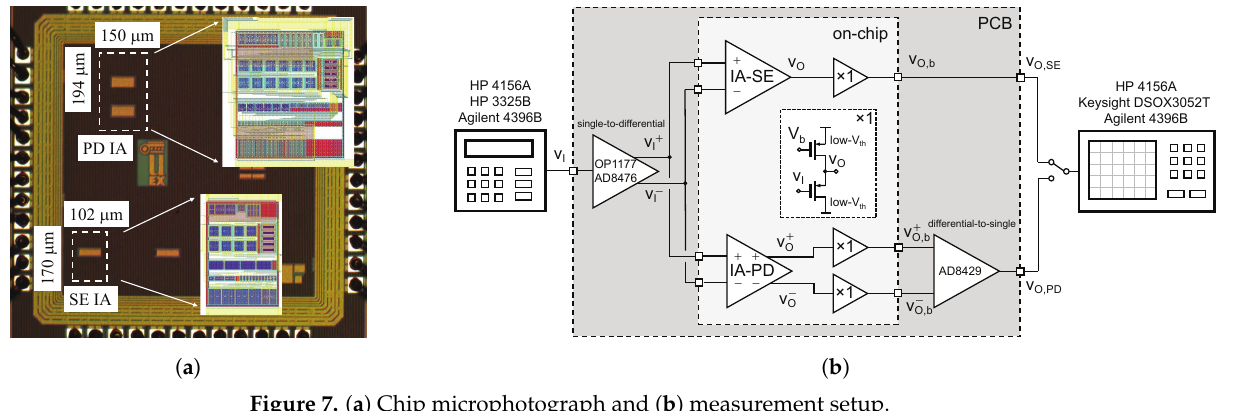
Figure 7. ( a ) Chip microphotograph and ( b ) measurement setup. Table 2. Transistor aspect ratios ( µ m/ µ m) for the SE (Figure 3) and the PD (Figure 4) ICF